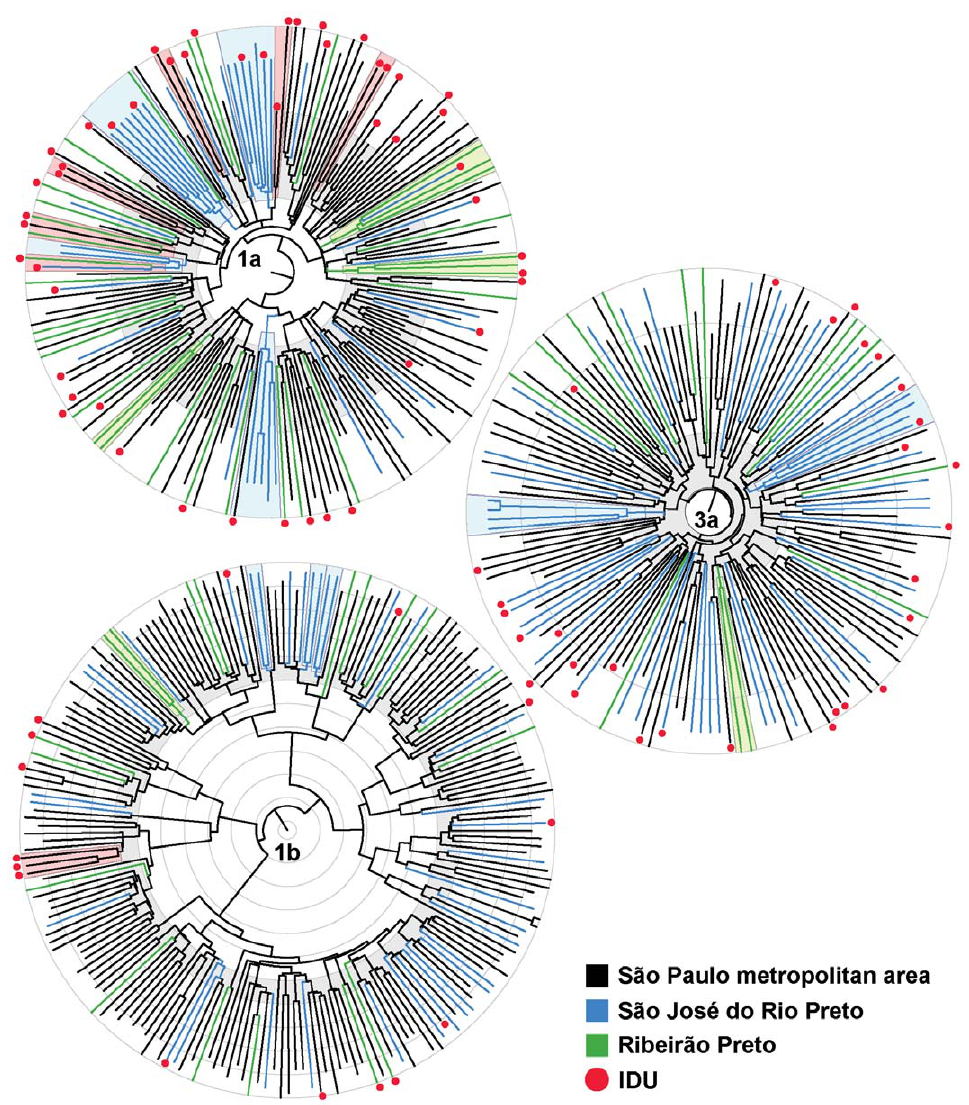
Figure 1. Phylogeographic and IDU risk analysis. We show Maximum Clade Credibility (MCC) trees for the main HCV genotypes in Sa˜o Paulo. Branches are colored according to the geographic locality of sampling, with IDUs shown as red dots at the tips. The highest posterior probability for the root of all trees revealed that the epicenter of HCV epidemics was the metropolitan area of Sa˜o Paulo. Highlighted sectors indicate ancestral nodes with posterior probability . 50% located outside the metropolitan area of Sa˜o Paulo (green in Ribeira˜o Preto and blue in Sa˜o Jose´ do Rio Preto). Branch lengths are scaled in years shown as concentric rings of 5 years. The grey concentric rings indicate that the epidemic expansion of HCV-1a in Sa˜o Jose´ do Rio Preto and Ribeira˜o Preto was synchronized with the growth in the metropolitan area of Sa˜o Paulo. Most of the IDUs are located within the HCV-1a and HCV-3a subtypes. Sectors highlighted in red indicate IDU clusters with posterior probability . 50%. All trees depicted non-IDU as the root state with the highest posterior